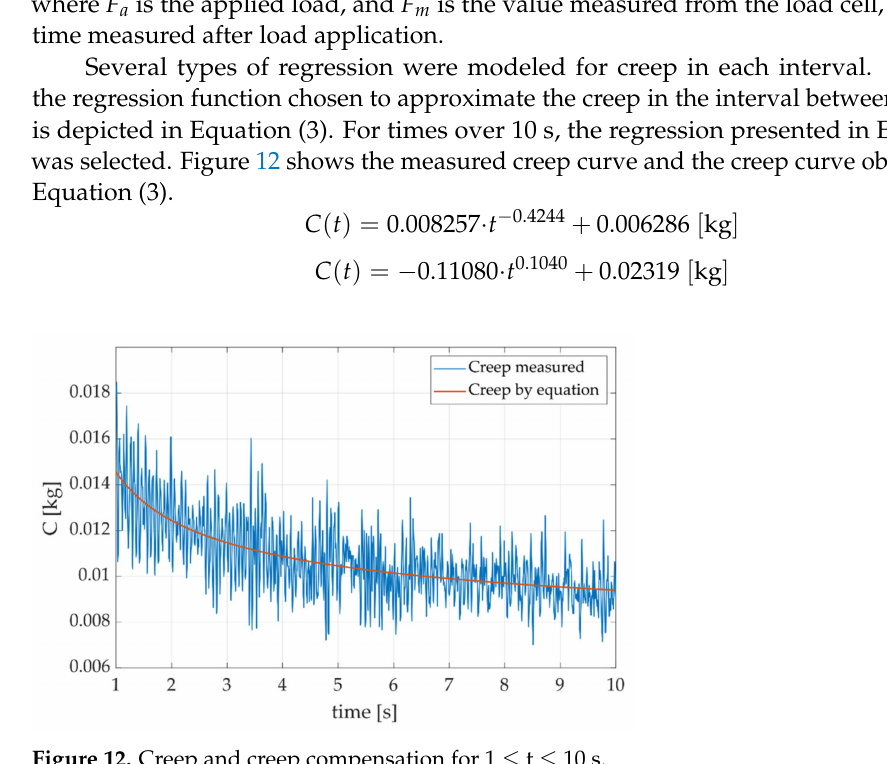
Figure 12. Creep and creep compensation for 1 ≤ t ≤ 10